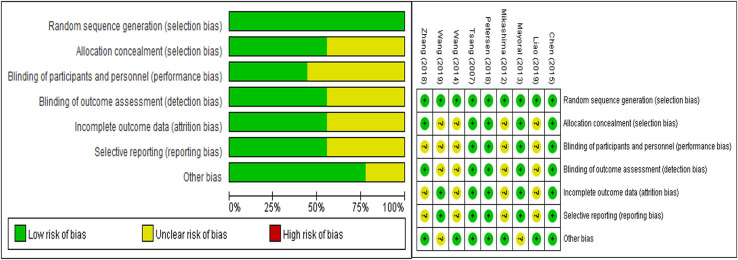
Risk of bias graph.